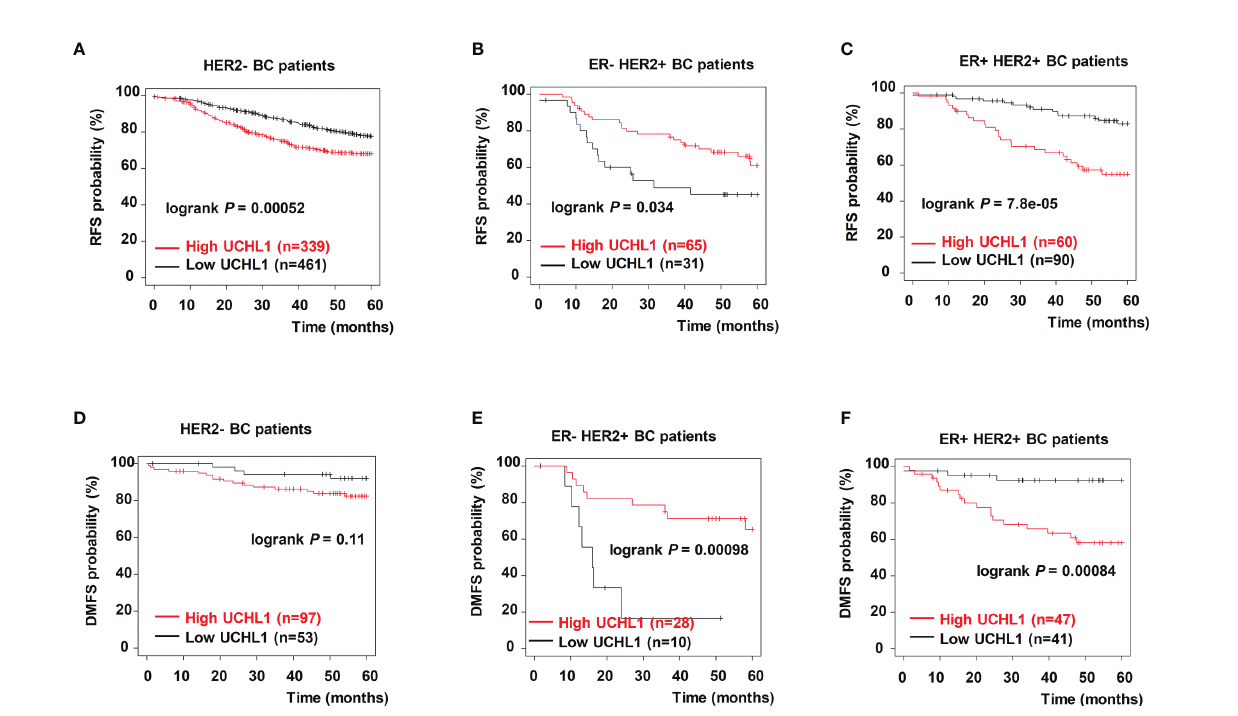
FIGURE 6 | Upregulation of UCHL1 correlated with poor prognosis in patients with different subtypes of BC. Kaplan – Meier analysis of RFS and distant metastasis free survival (DMFS) in 54 patients with BC based on UCHL1 expression and different genetic typing are indicated (A – C) . RFS and DMFS, as determined according to UCHL1 expression and genetic typing in BC samples from the Kaplan – Meier-plotter dataset (D – F) . Statistical analysis was carried out by Log-rank